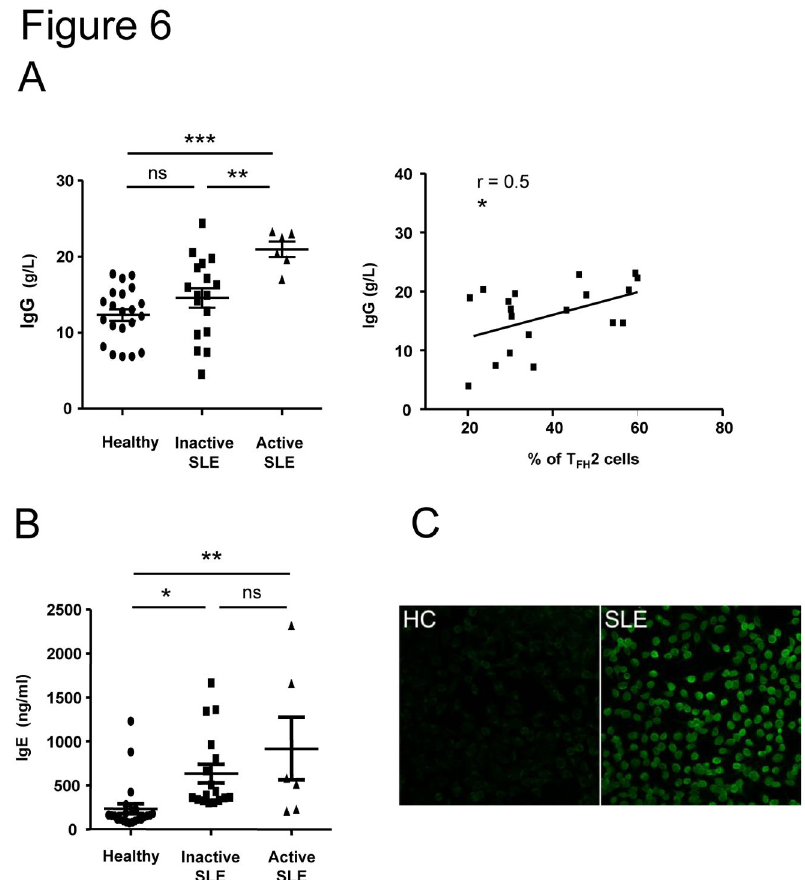
Figure 6. IgE levels are increased in the serum of SLE patients. The quantification of IgG and IgE levels in the serum of inactive SLE patients (n = 17), active SLE patients (n = 6) and sex and age-matched healthy controls (n = 21) were determined by a sandwich ELISA assay. Results are expressed as the mean IgG concentration (g/L; A) or IgE concentration (ng/ml; B) from duplicate wells and correlation between IgG levels and T 2 cell frequency is represented (A). Each data point represents an FH individual subject and horizontal lines show the mean ± sem. * p < 0.05, ** p < 0.01 (unpaired Student’s t test and Pearson correlation coefficient). ns: not significant. ANA IgE in sera were detected using Hep-2 cells as substrate (C). Compared to healthy individual sera (HC, shown as an example), some IgG-depleted sera from lupus patients (4/12) (SLE, 1 out of 4 representative picture) yielded homogeneous nuclear